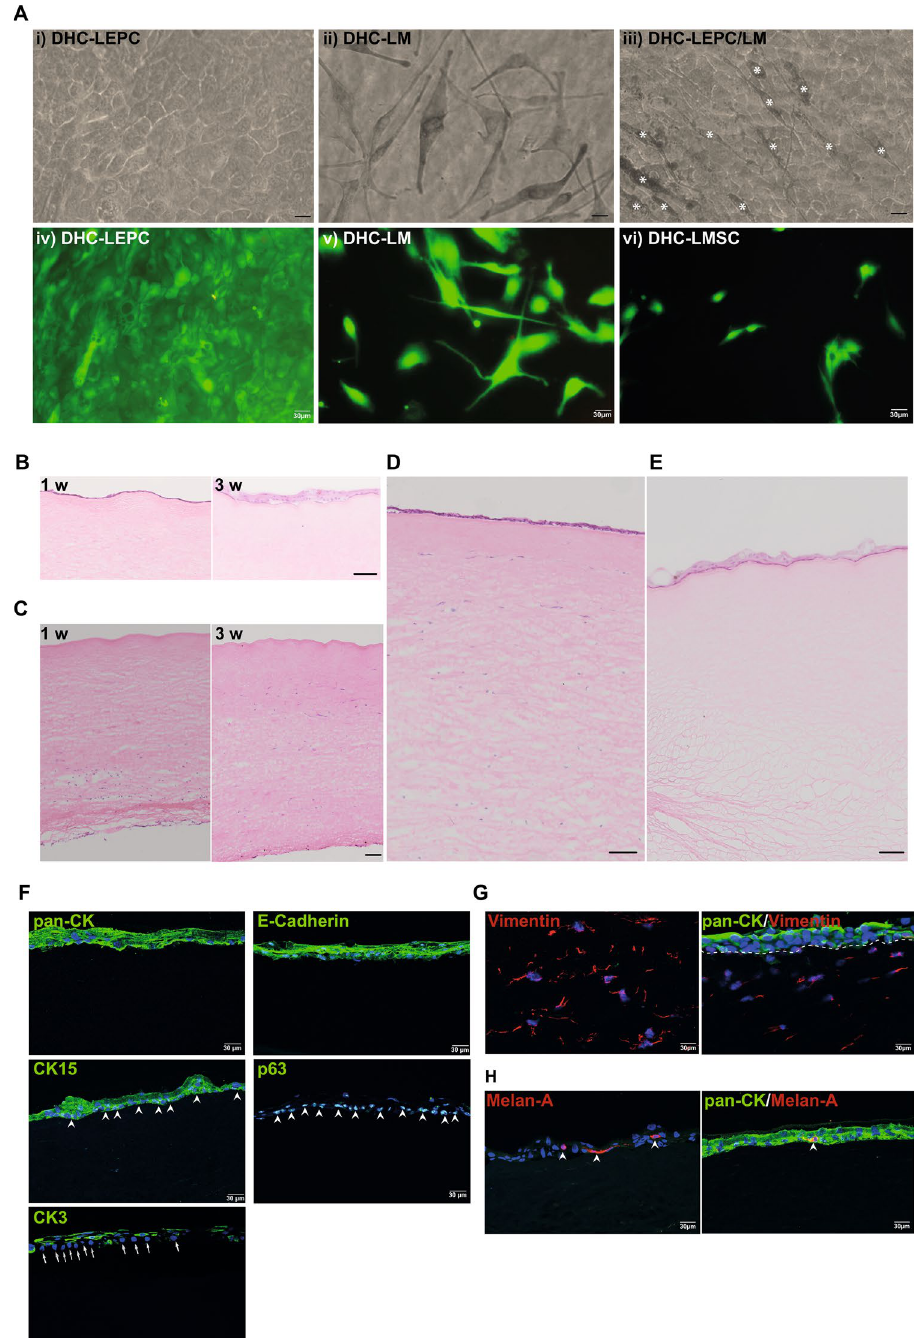
Figure 4. In vitro recellularization of the decellularized human cornea (DHC) ( A ) Phase contrast micrographs of LEPC (i); LM (ii); and LEPC/LM scaffolds showing intermingled melanocytes (iii, white asterisk) in the epithelial cell layer on DHC. Scale bar = 20 µm. Live/dead viability assay after 24 h of cultivation of LEPC, LMSC, and LM on DHC (iv–vi). ( B ) Light microscopic analysis of DHC- LEPC scaffolds showing cell monolayers after 1 week (1 w) and stratified epithelium (3 w) by hematoxylin and eosin staining (H&E) on the anterior surface. Scale bar—100 µm. ( C ) The injected stromal cells in DHC showing the stromal cells on the posterior side at 1-week culture and migrated to the anterior side after 3 weeks by H&E staining. Scale bar—100 µm ( D ) DHC-LEPC/LMSC scaffold after 3 weeks cultivation showing stratified epithelium and presence of stromal cells throughout the stroma by H&E staining ( E ) DHC-LEPC/LM scaffold showing stratified epithelium after 3 weeks of cultivation. Scale bar—100 µm ( F ) Immunofluorescence staining of DHL-LEPC scaffolds showing the expression of CK15 and p63 (green) at basal layers of epithelial cells (arrowheads); CK3 expression (green) in suprabasal cells but not in basal cells (arrows); E(epithelial)-cadherin and cytokeratin (pan-CK) expression (green) in all human limbal epithelial cells on DHC. ( G ) DHL-LEPC/LMSC scaffolds showing the vimentin expression on stromal cells and cytokeratin (pan-CK) expression (green) on epithelial layers. The dashed line separated the epithelium and stroma. ( H ) DHL- LEPC/LM scaffolds showing the melan-A (red) positive melanocytes (arrowheads) in the epithelial layers (pan-CK, green). LEPC limbal epithelial progenitor cells; LMSC limbal mesenchymal stromal cells, LM limbal melanocytes, pan-CK pan-cytokeratin,